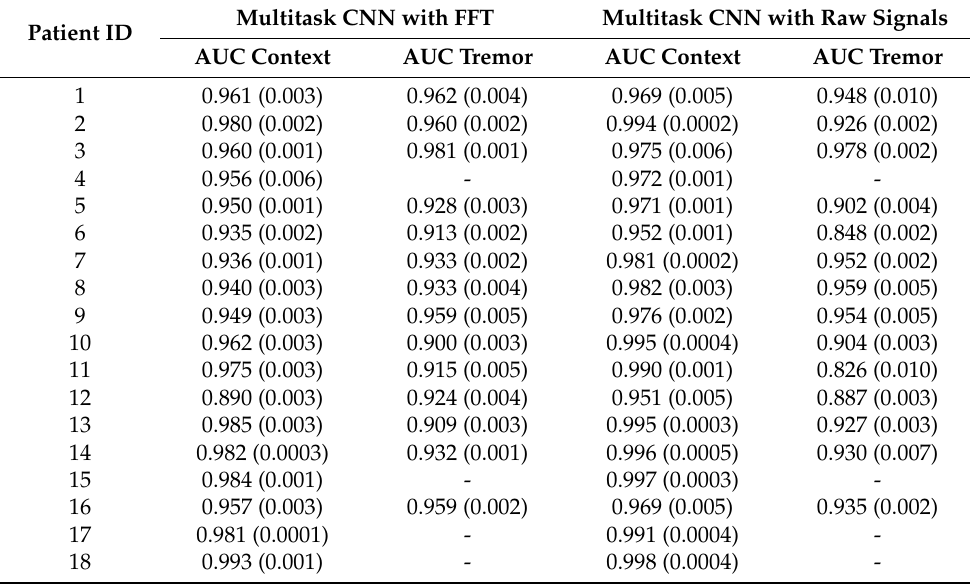
Table 7. Area under the curve (AUC) results per patient of the multitask CNN models using LOSO evaluation. Multitask CNN with FFT Multitask CNN with Raw Patient ID